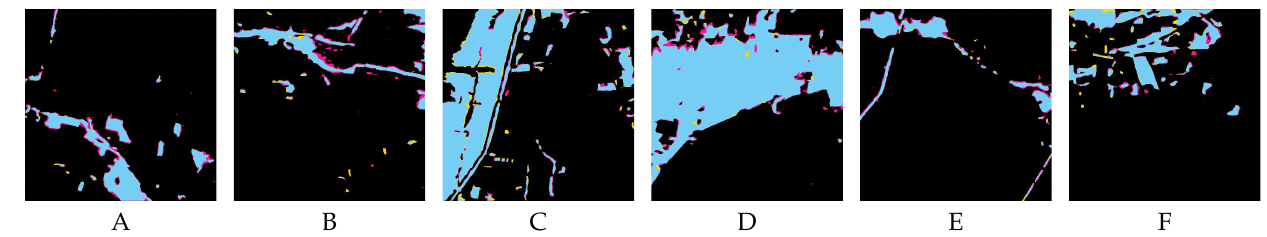
Figure 12. The comparison between the ground truth of regions ( A – F ), and the results generated by MS-Deeplab. Yellow denotes omission errors, red denotes commission errors and blue denotes correctly classified water